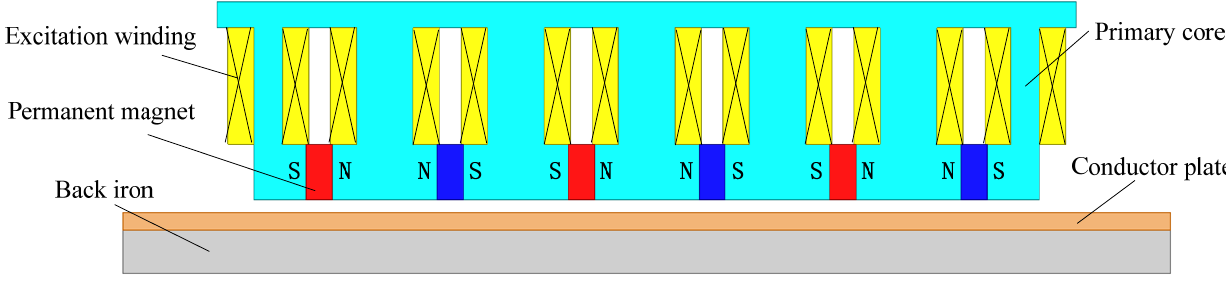
Figure 1. Structure of the hybrid excitation linear eddy current brake.